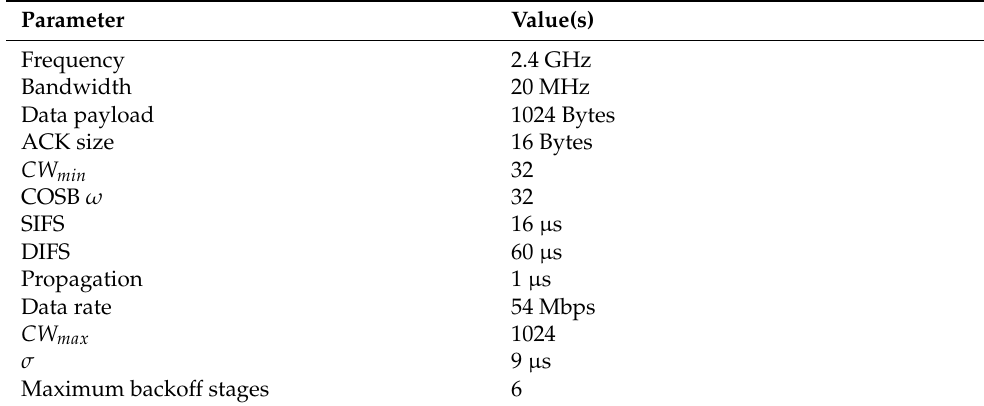
Table 1. Evaluation parameters and their